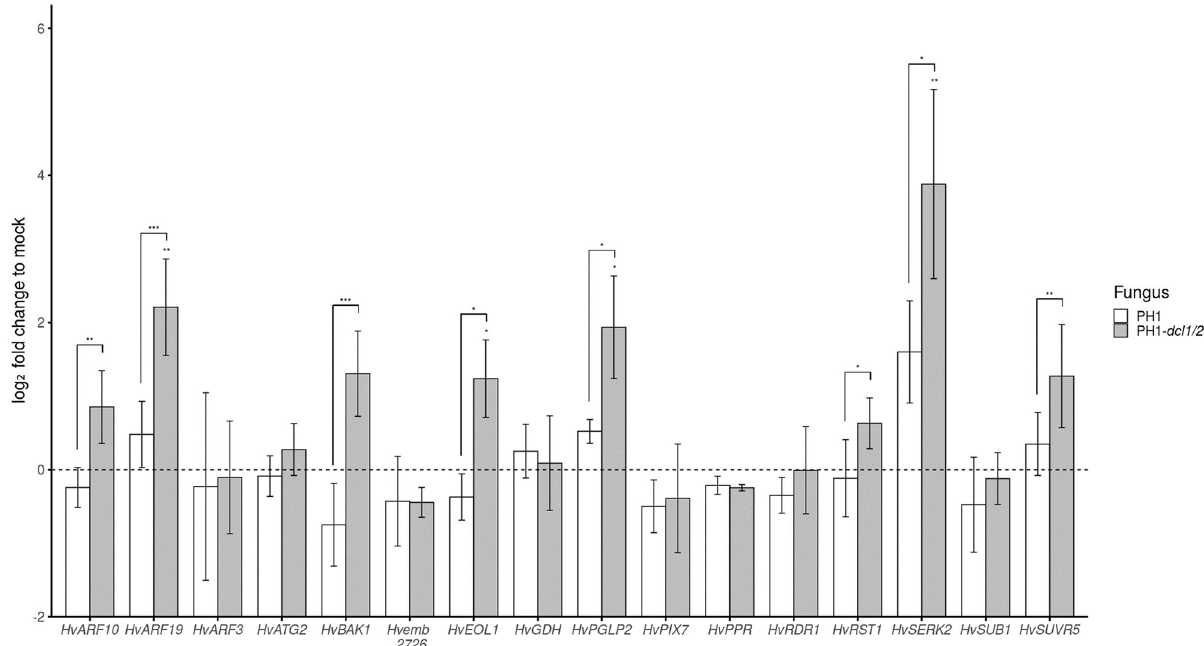
Fig 2. Relative expression (log2 fold) of potential barley target genes for fungal sRNAs in leaves infected with Fusarium graminearum wt strain PH1 vs. PH1-dcl1/2. Expression was normalized against barley Ubiquitin ( HvUBQ ) and subsequently against the Δ ct of the uninfected control (mock treatment). Bars represent the mean ± SE of three independent biological replicates. Significant differences were calculated for the expression of a respective gene in PH1 vs. PH1- dcl1/2 -infected samples and PH1 vs. controls. The dotted line shows the expression level of mock treatment. (Student‘s t -test, (paired) one sided, � P < 0.1, �� P < 0.05, ��� P < 0.01).